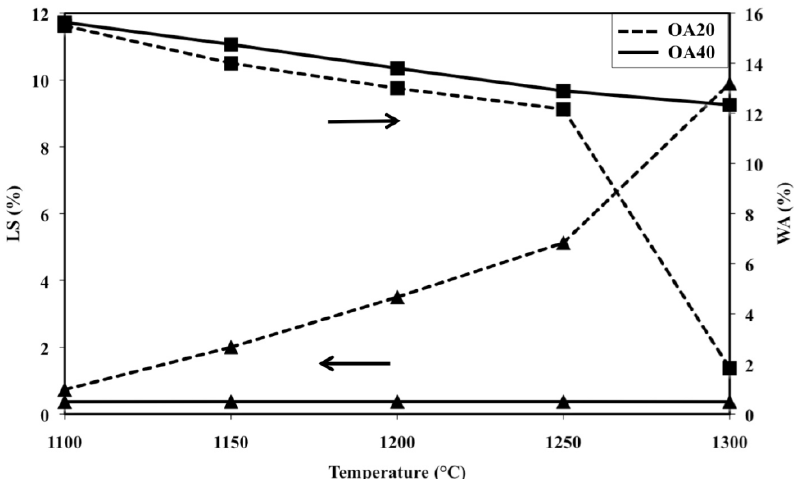
Figure 8. Linear shrinkage (LS) and water absorption (WA) as a function of firing temperature of samples OA20 and OA40 (LS: ▲ ; WA: ■ ).